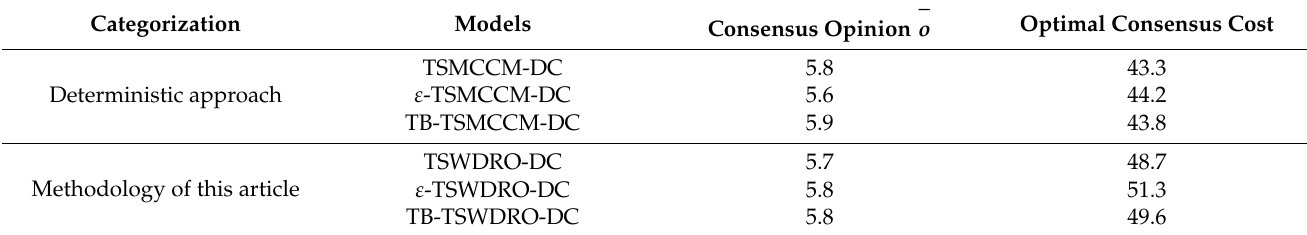
Table 3. Comparison of optimal results of different cost consensus models.